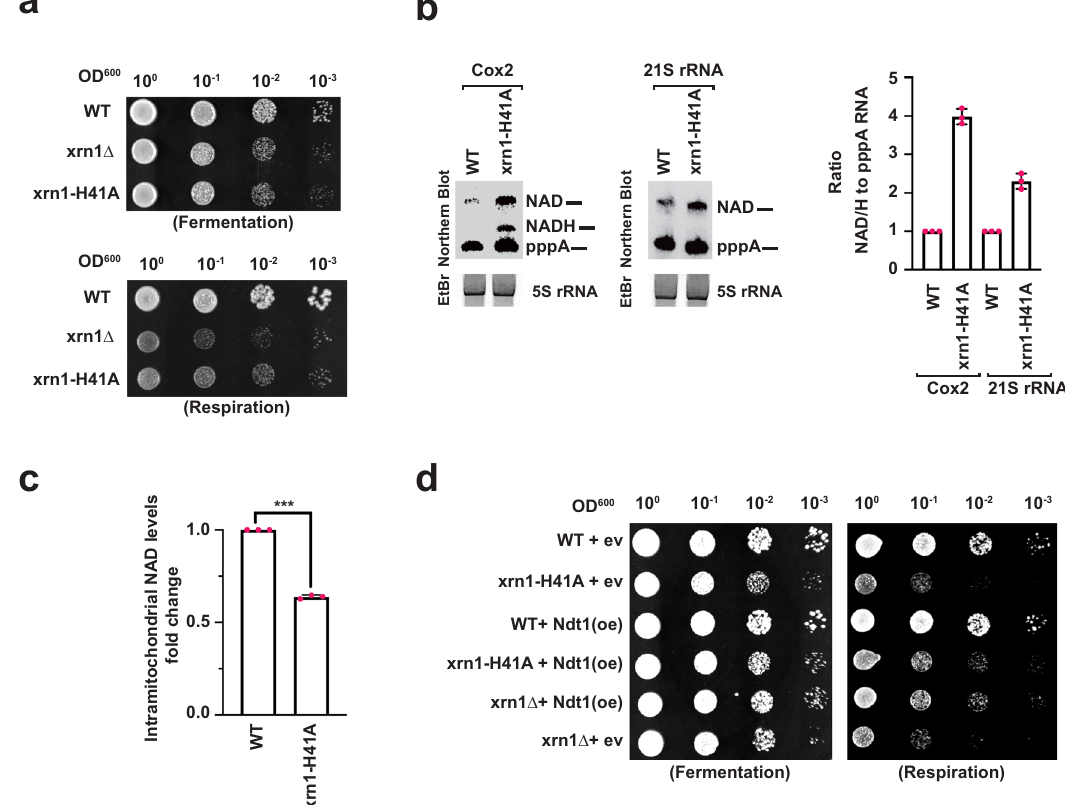
Fig. 5 Xrn1 deNADding activity is critical in maintaining intramitochondrial NAD steady state levels. a Tenfold serial dilution of WT, xrn1 Δ and xrn1 - H41A were spotted onto solid YPD (Fermentation) and YPG (Respiration) plates and incubated at 30 °C. b Northern Blot analysis of DNAzyme-generated 5 ′ -end-containing subfragments of Cox2 and 21S rRNA from WT, xrn1 Δ and xrn1 -H41A grown in YPG media with the quantitation on the right (Average of three independent experiments with error bars represent ±SD). Source data are provided in Source Data File. c Intramitochondrial NAD/NADH levels in WT and xrn1 -H41A cells grown on YPG. Data are presented relative to the WT cells set to 1 and derived from three biological replicates (Average of three independent experiments with error bars represent ±SEM; two sided unpaired t test; *** p = 0.000001). Source data are provided in Source Data File. d Tenfold serial dilution of WT, xrn1 Δ and xrn1 -H41A harboring either an empty vector (ev) — without Ndt1 or a multicopy plasmid containing Ndt1 under a strong promoter — over expressed (oe) were spotted onto solid YPD and YPG plates and incubated at 30